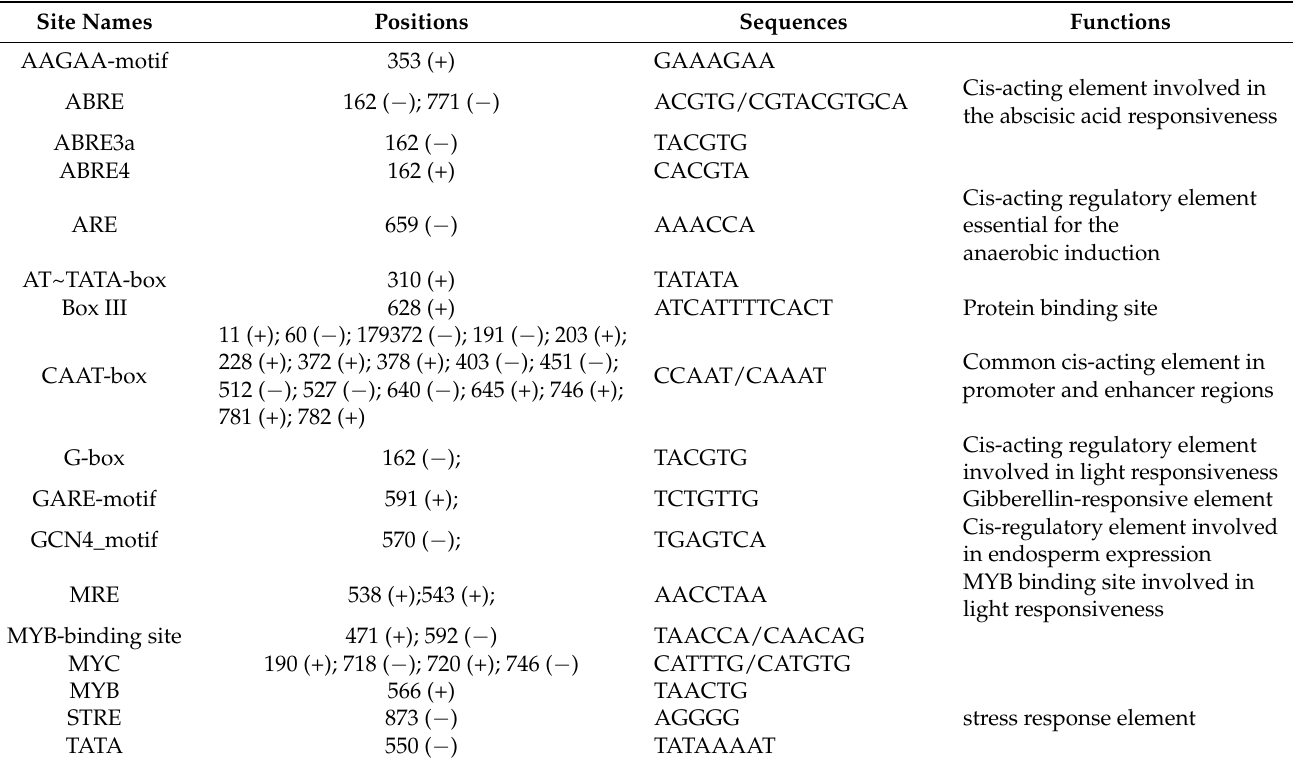
Table 1. Motif analyses of the HmoCYP76AD1 promoter.